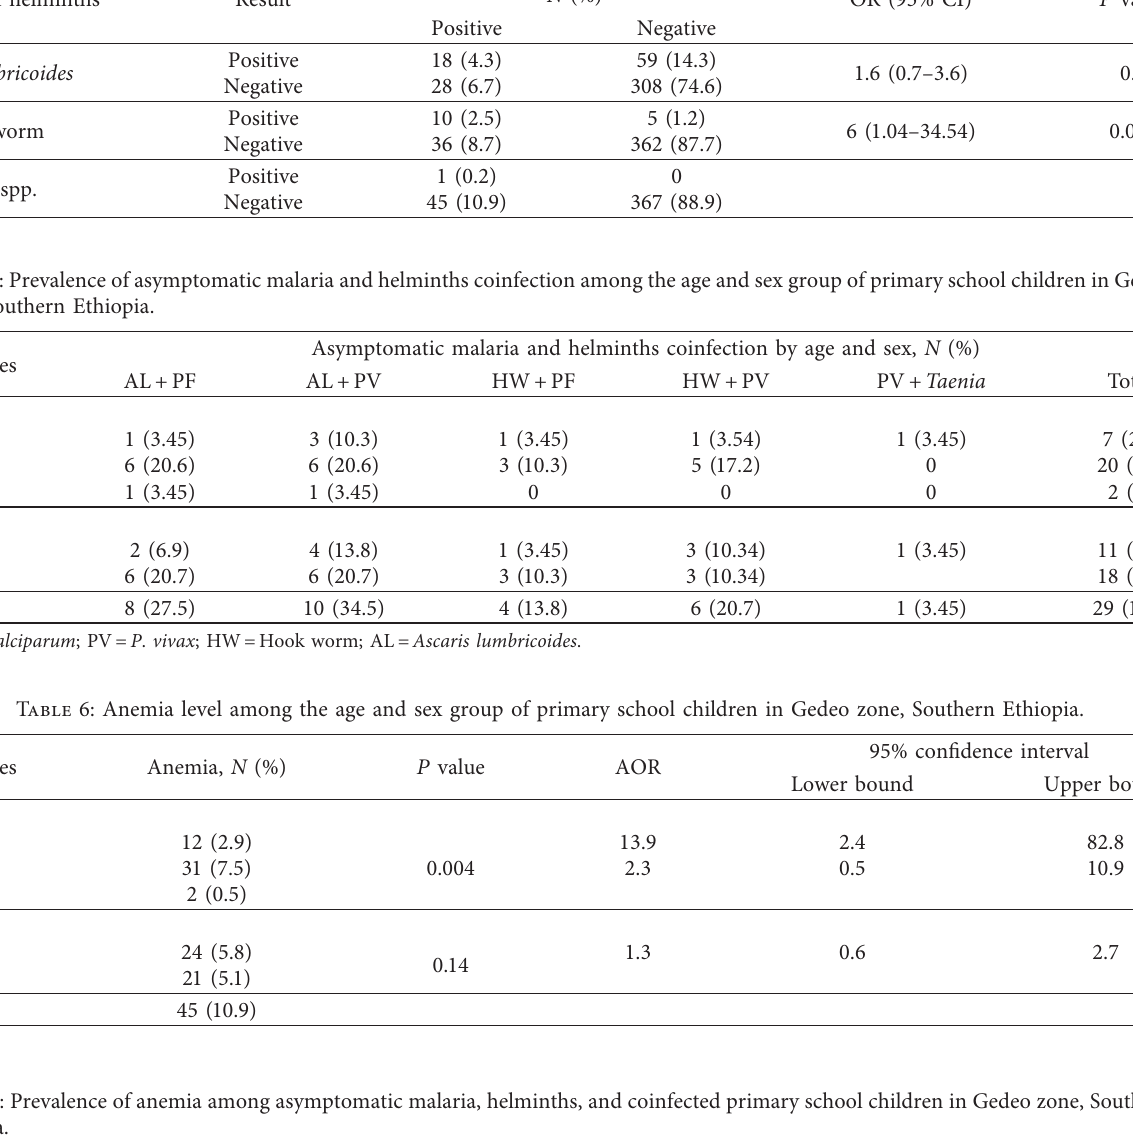
Table 4: Prevalence of asymptomatic malaria and helminths coinfection among primary school children in Gedeo zone, Southern Ethiopia. Type of helminths Result